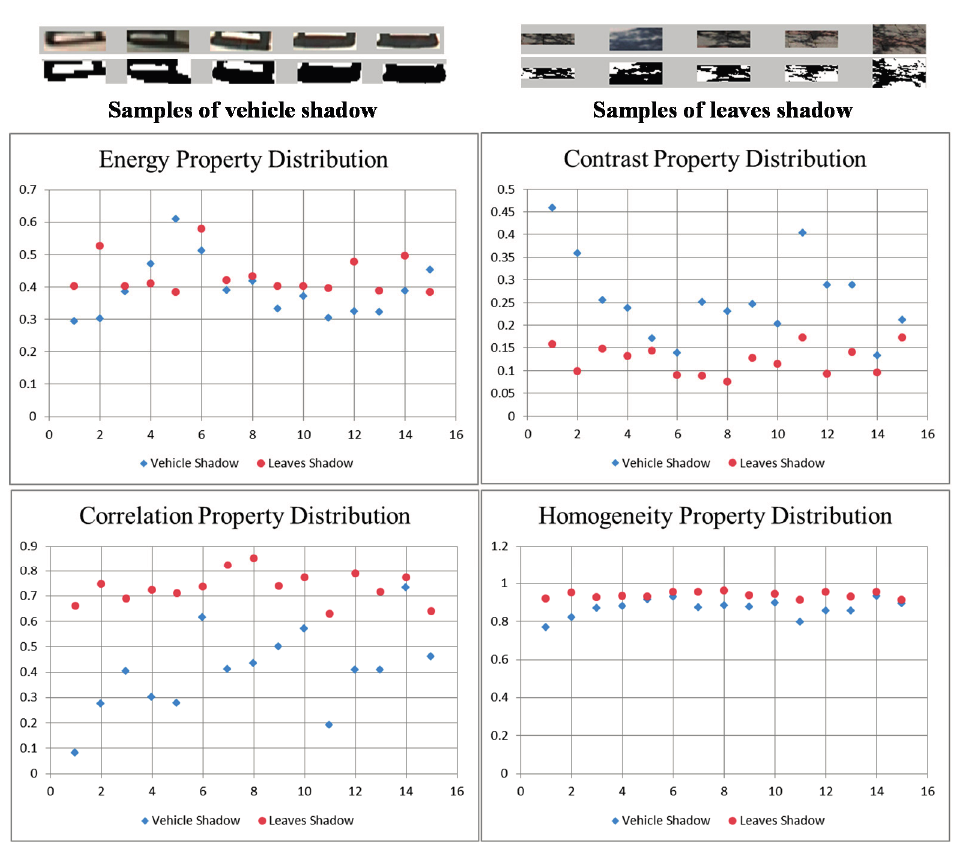
Figure 11. Texture property distribution